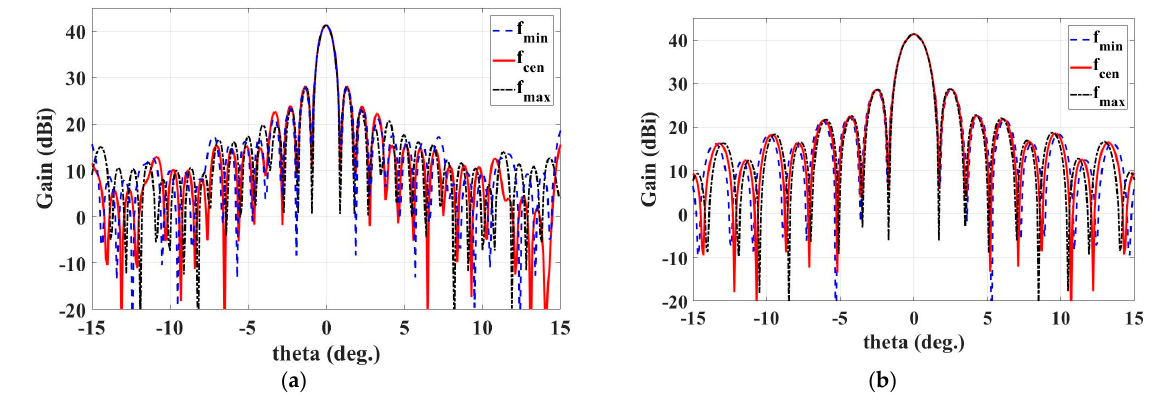
Figure 20. Antenna patterns of the S-STEP SAR payload in ( a ) azimuth and ( b ) elevation.